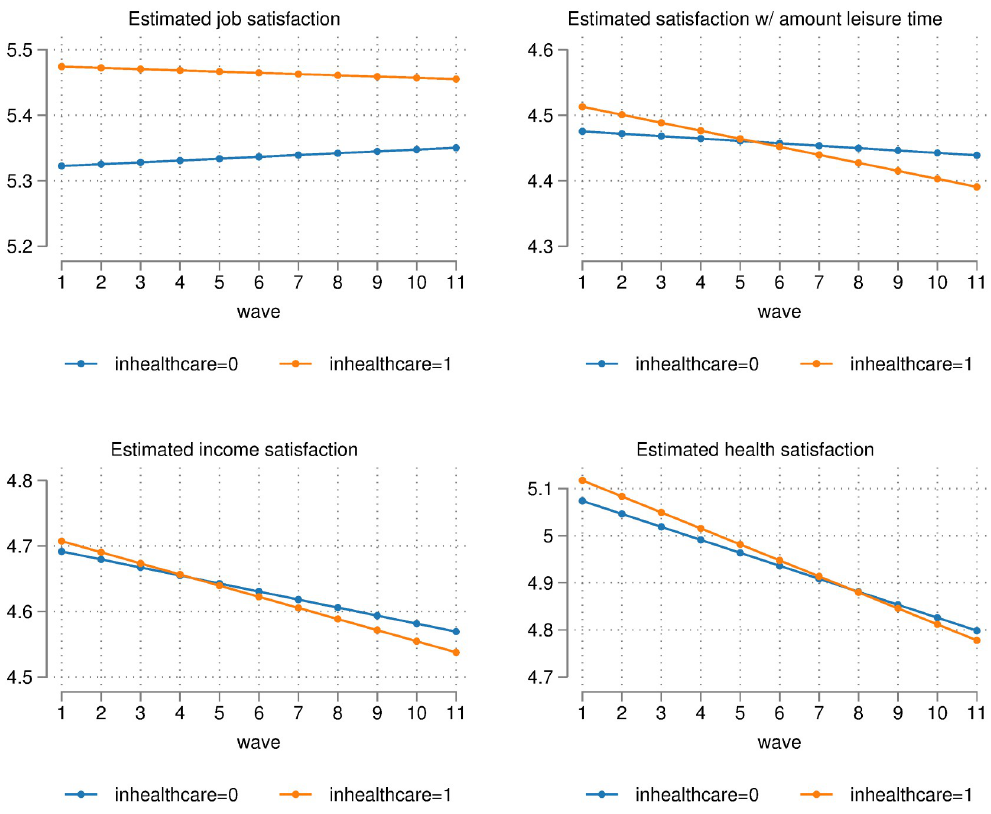
Fig 2. Difference in satisfaction levels of healthcare workers over time, relative to workers outside healthcare (plotted using FE regressions shown in Table 1).